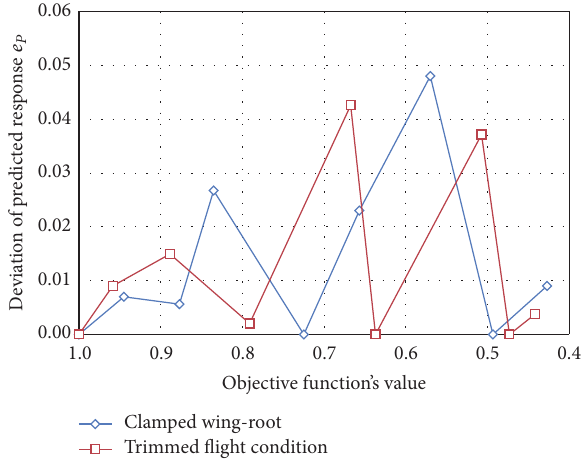
Figure 11: Deviation of the prediction gust response for the cases with and without the aircraft rigid-body